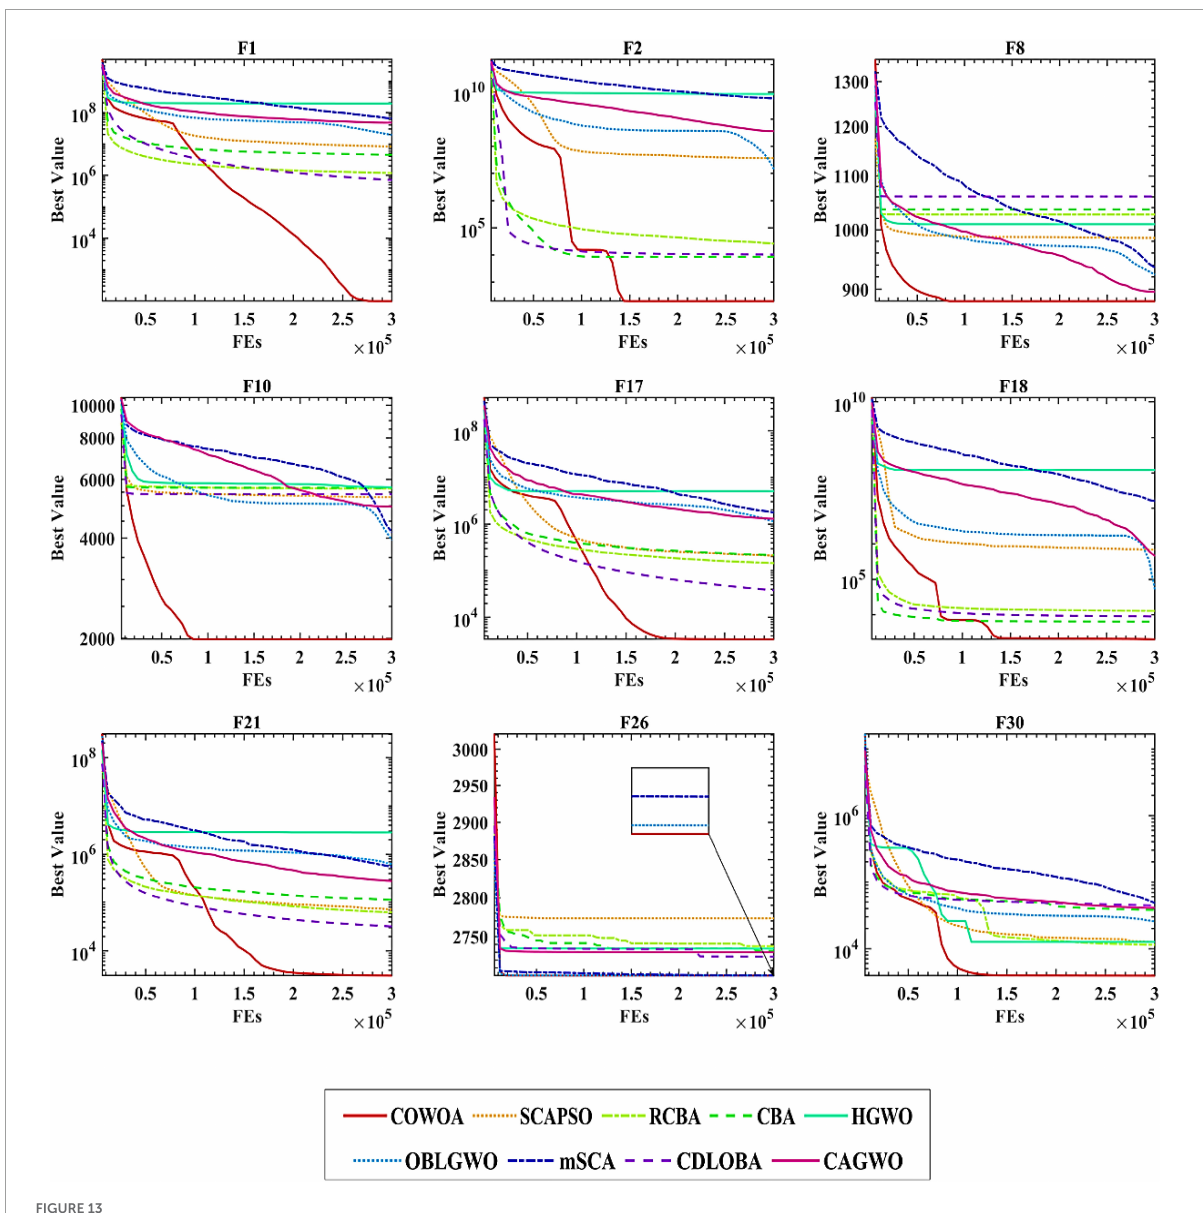
FIGURE13 Convergence curves of COWOA with the well-known variant algorithms.